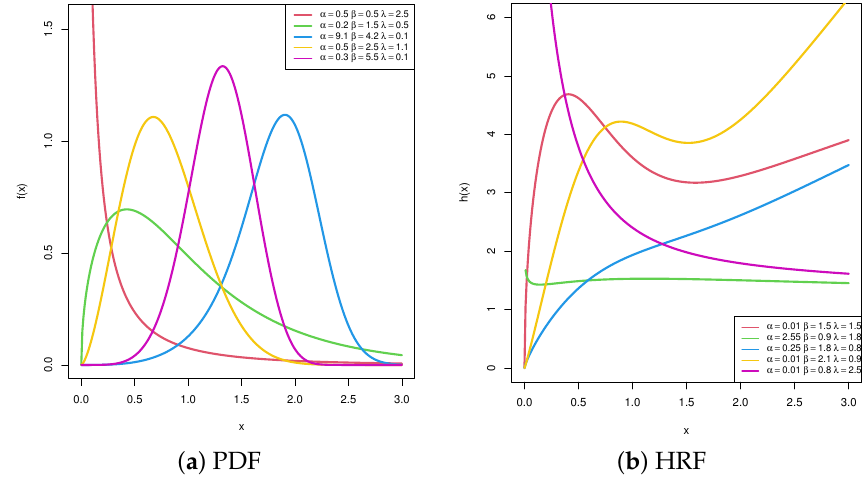
Figure 1. The PDFs and HRFs of the APW distribution using some specified